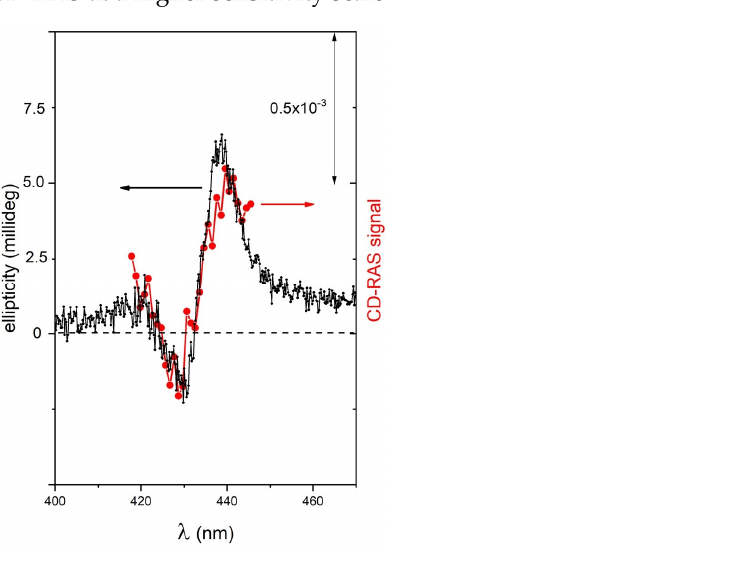
Figure 5. CD-RAS experimental spectrum for sample A2 (red curve, right vertical axis), compared with the ellipticity spectrum measured for the same sample by a commercial spectrometer for circular dichroism (black curve, left vertical axis). The double-arrow reported in the figure is the unit for the CD-RAS data. The CD-RAS spectrum was corrected by subtracting the background measured (in the